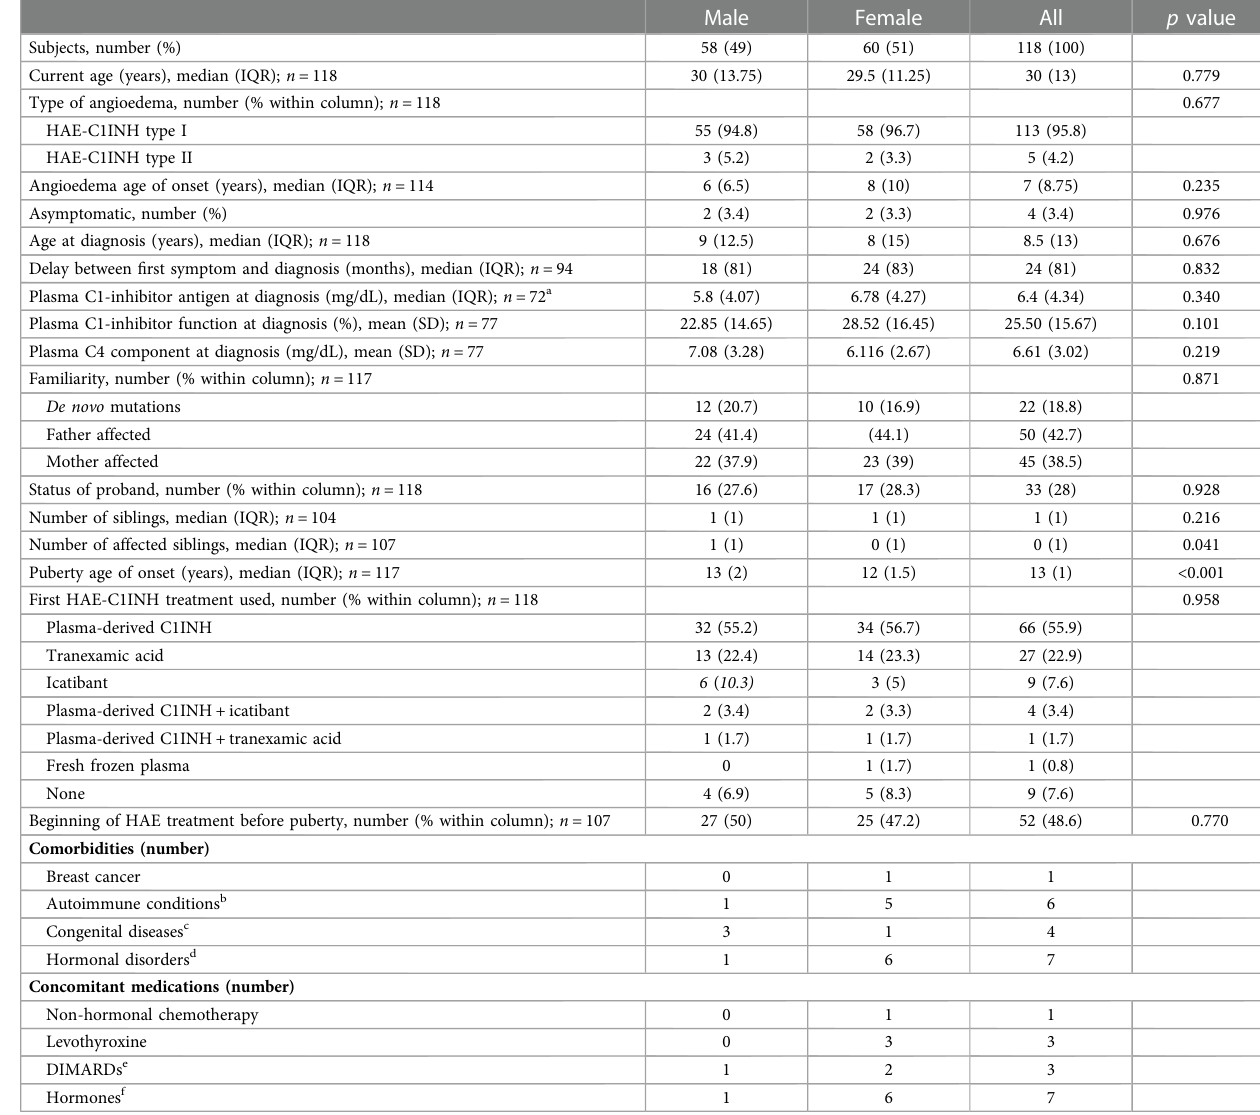
TABLE 1 Demographic and clinical characteristics of patients.